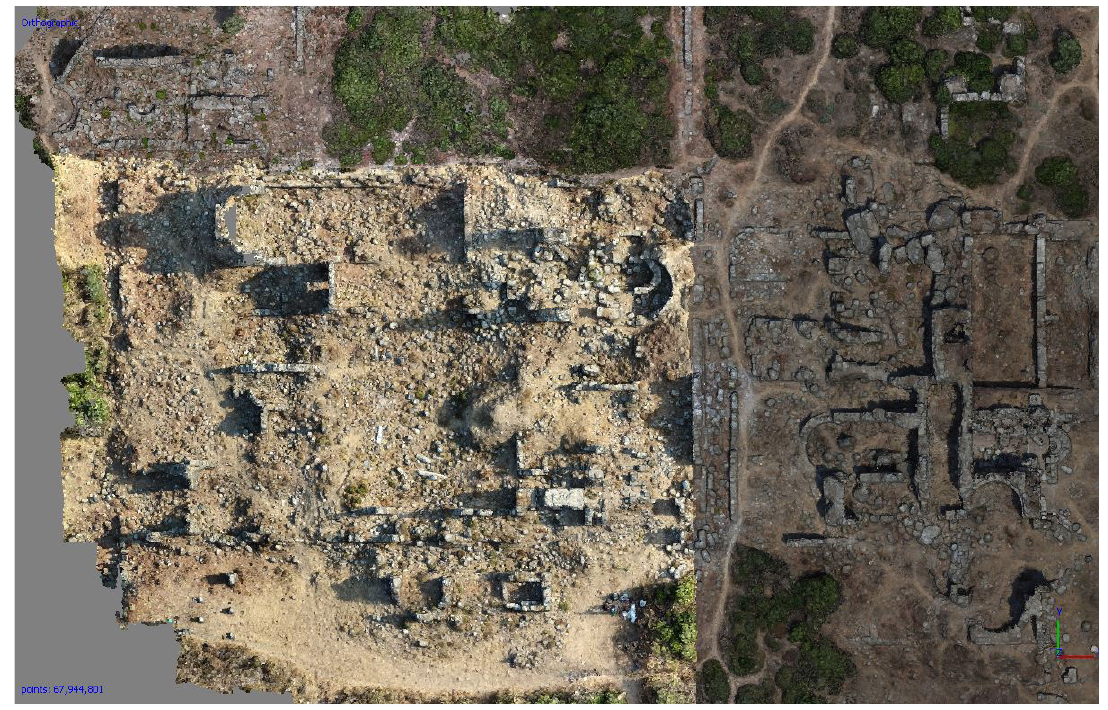
Figure 9.1. Point cloud view (© M. Hernández Cordero).